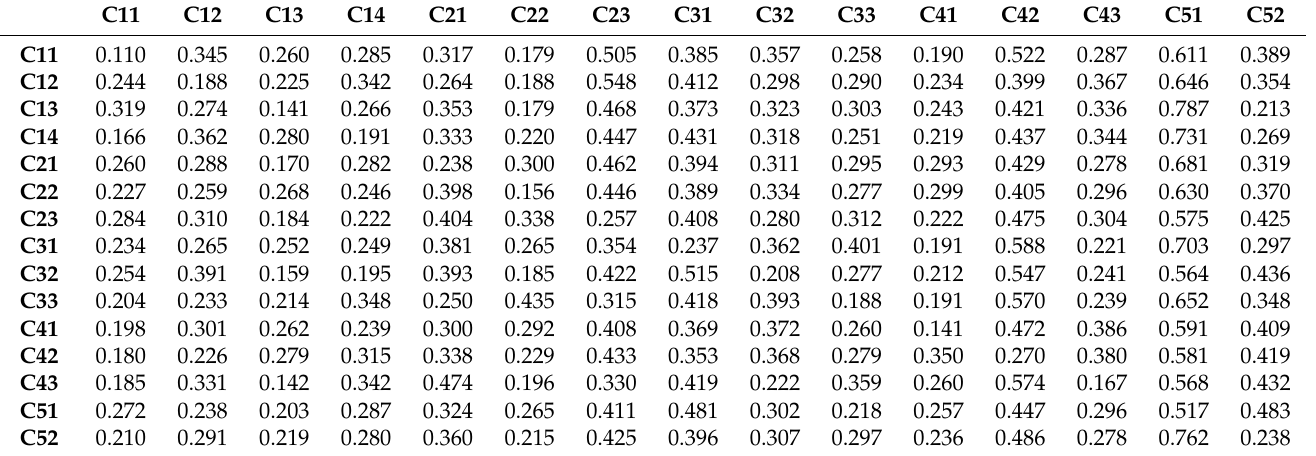
Table A9. The normalized total relation matrix (Tc).